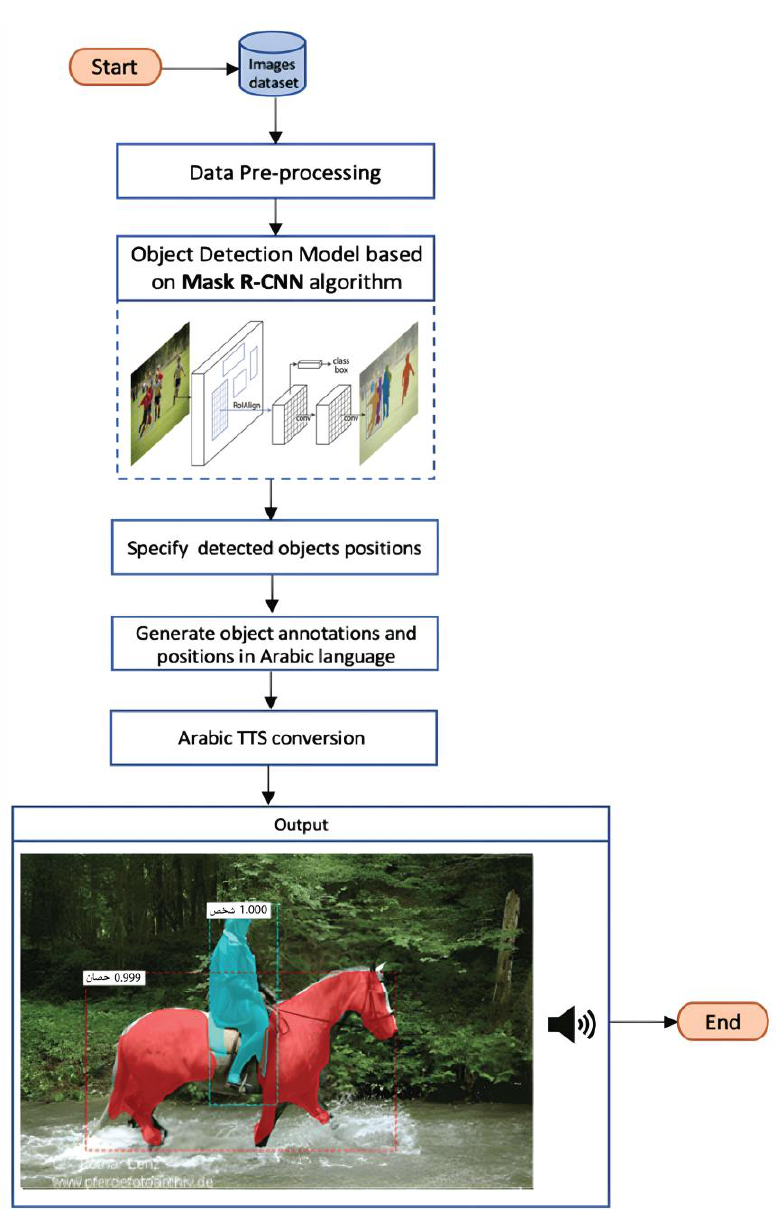
(cid:9) (cid:224)(cid:65)(cid:146)(cid:107) means